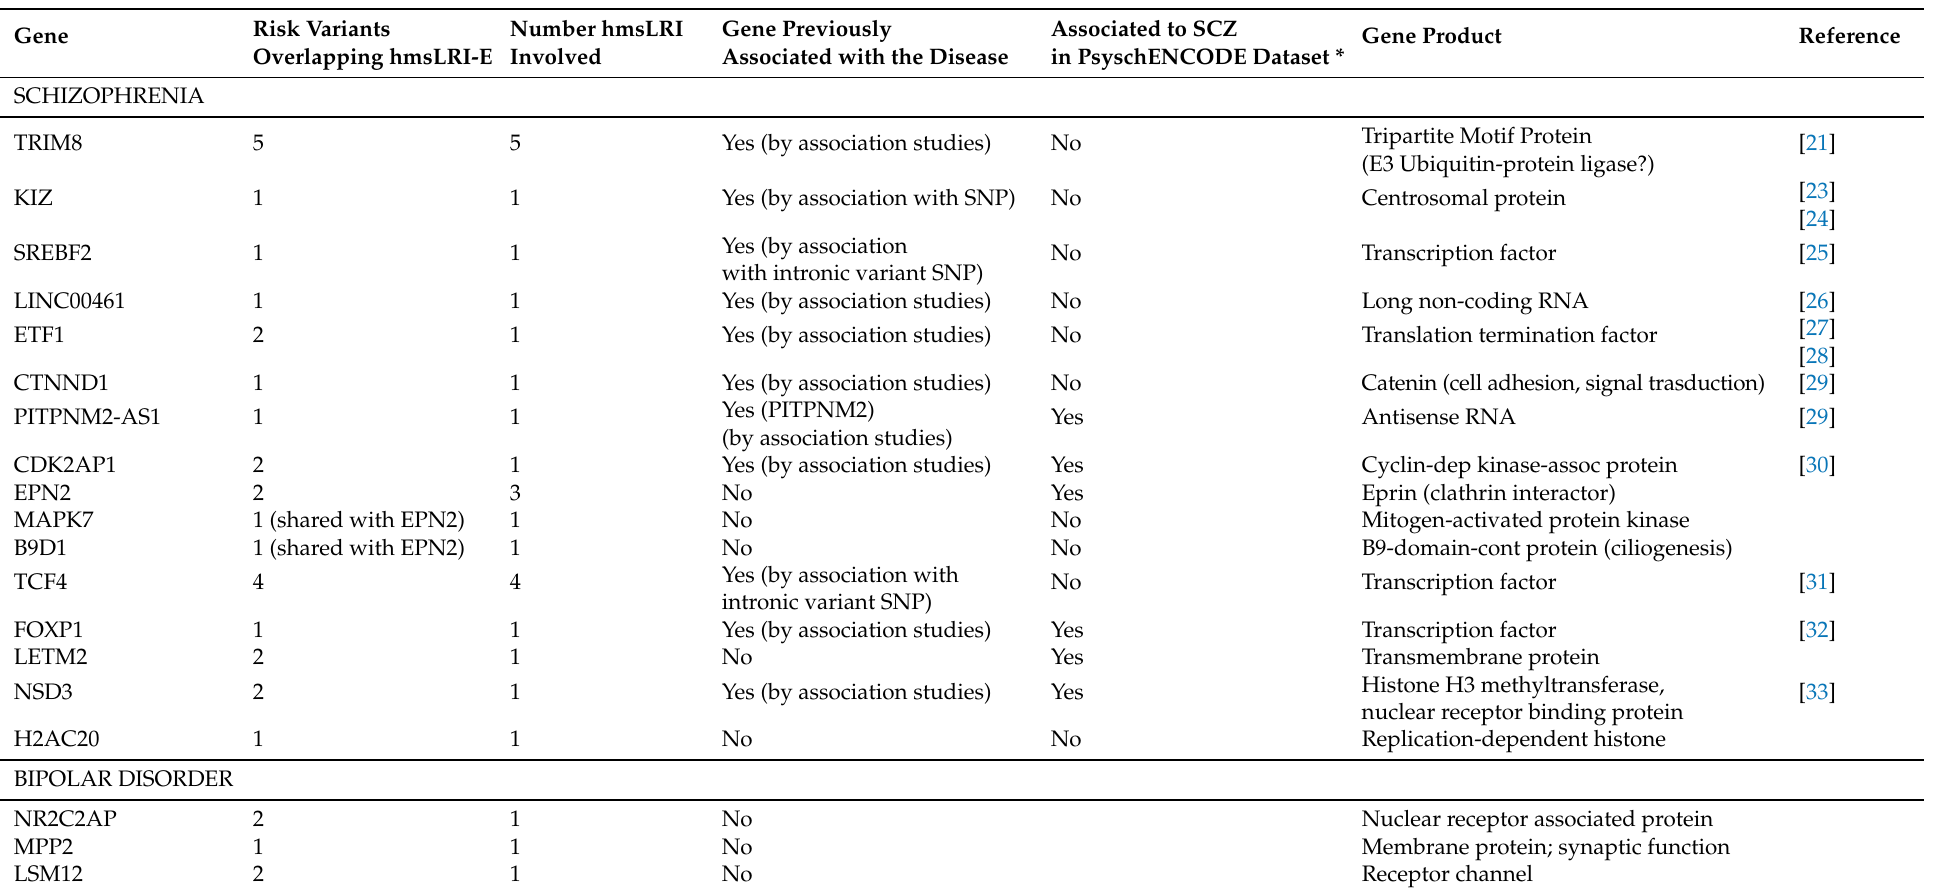
Table 3. Sequence variants associated with Schizophrenia and Bipolar disorder overlap with human putative enhancers, involved in human–mouse syntenic long-range interactions (hmsLRI-E, see Figure 1, Table 1) . “Gene” (first column) is the gene whose promoter is involved in the human–mouse syntenic long-range interaction (hmsLRI); the sequence variants are located within the connected hmsLRI-E. We searched our hmsLRI-E for the GWAS-derived variants with posterior probabilities of association (PPA) score larger than 1% with schizophrenia and bipolar disorder; these potential causal variants were derived from the previous analyses by (Li et al., 2021) [11] (see their Table S25). * PsychENCODE association of genes to schizophrenia was by HiC connection between the variant-containing DNA region and the gene promoter, and by eQTL data (see Wang et al., 2018 [14] and (http://resource.psychencode.org/, accessed on 4 March